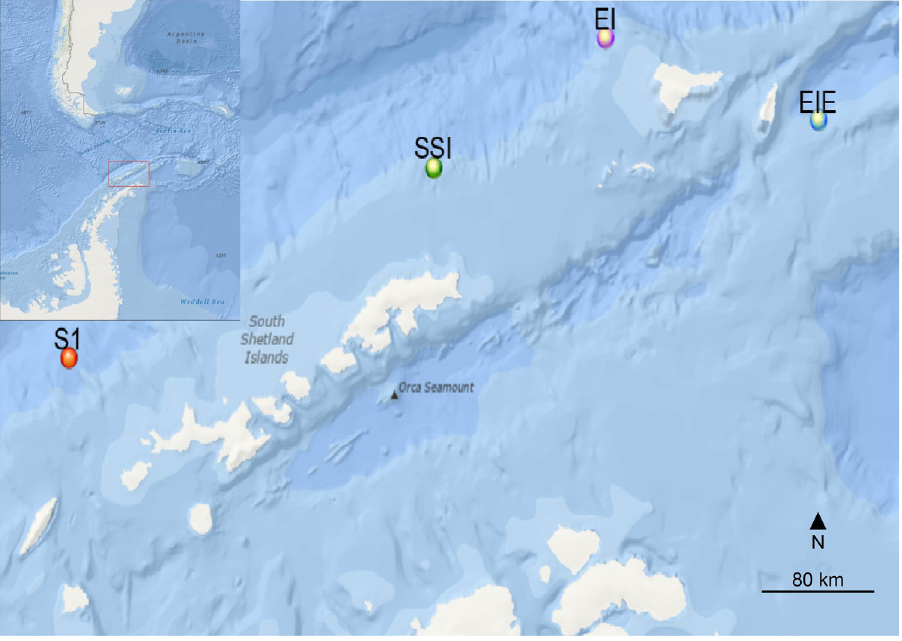
Fig 1. Study area map. Acoustic recorder deployment sites: Site 1 (S1, red) was used 2001–2003, Elephant Island (EI, purple) in 2003 & 2014, South Shetland Island (SSI, green) in 2015, and Elephant Island East (EIE, blue) in 2016. Inset map in top left corner shows study area in red square. Map images were obtained from USGS National Map Viewer.